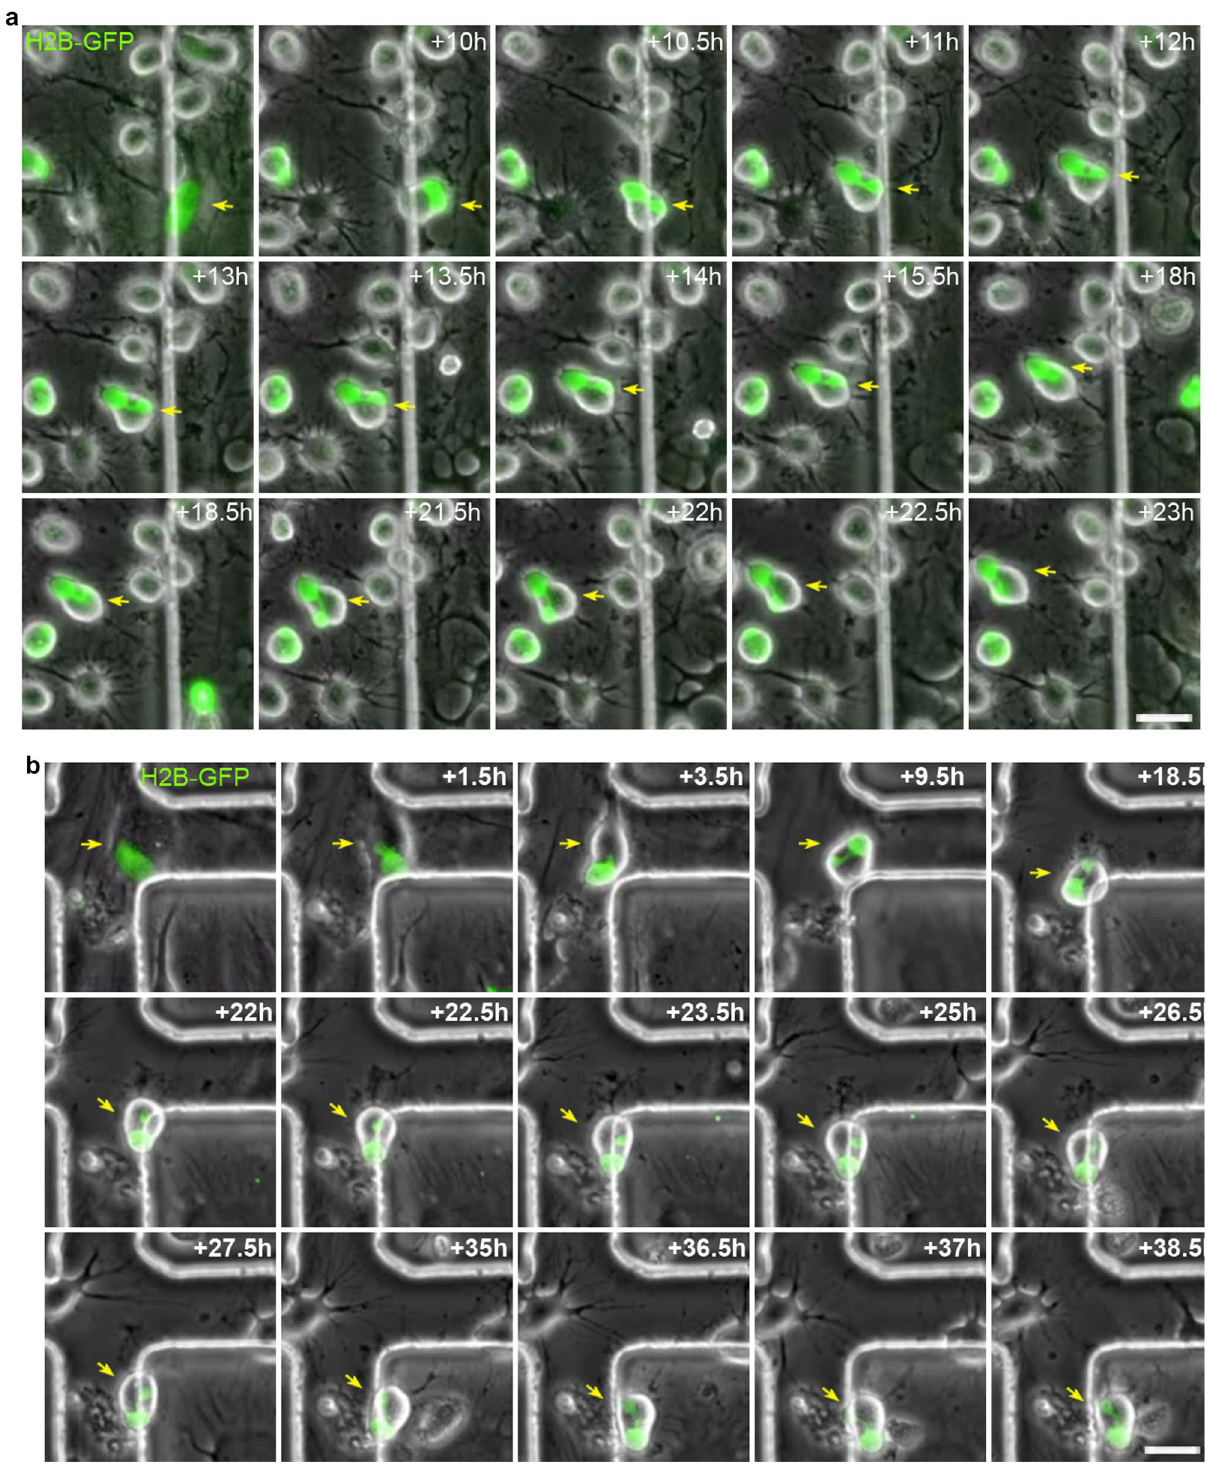
Figure 8. hBM-MSC-derived intermediate cells with lobed nuclei position their nucleus at the front of the cell during migration. ( a ) Time-lapse microscopy showed that histone H2B-GFP-expressing, hBM-MSC-derived intermediate cells with lobed nuclei positioned their nucleus at the front of the cell during migration. ( b ) Futhermore, histone H2B-GFP- expressing, hBM-MSC-derived intermediate cells with lobed nuclei positioned their largest lobe at the front of the cell during migration. Scale bar: 25